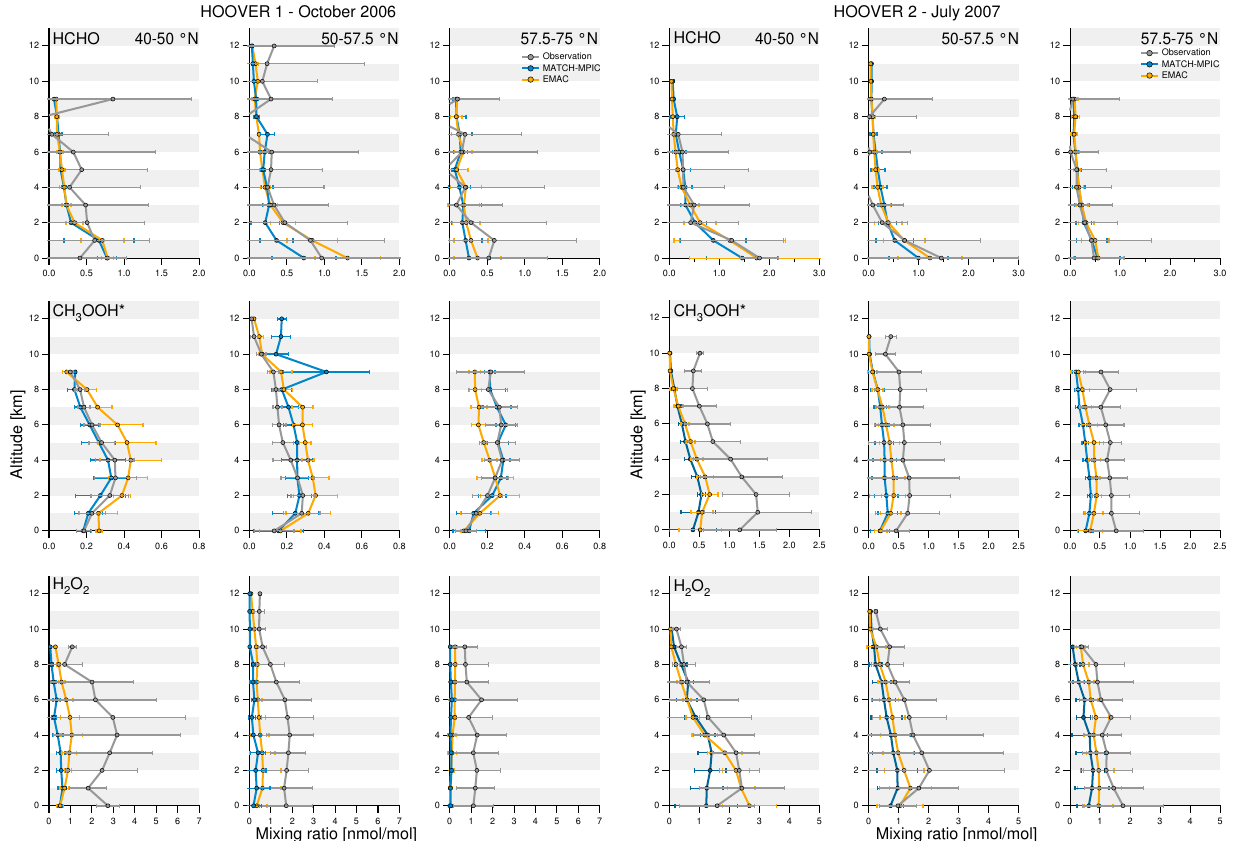
Fig. 6. Vertical profiles of H 2 O 2 , CH 3 OOH ∗ and HCHO from HOOVER 1 (left panels) and HOOVER 2 (right panels). The data is subdivided into 3 latitude ranges: 40–50 ◦ N, 50–57.5 ◦ N, 57.5–75 ◦ , representing southern, central and northern Europe. The median values of in-situ measurements (grey), EMAC simulations (orange) and MATCH-MPIC simulations (blue) are plotted for 1 km steps together with 2 sigma as error bars.